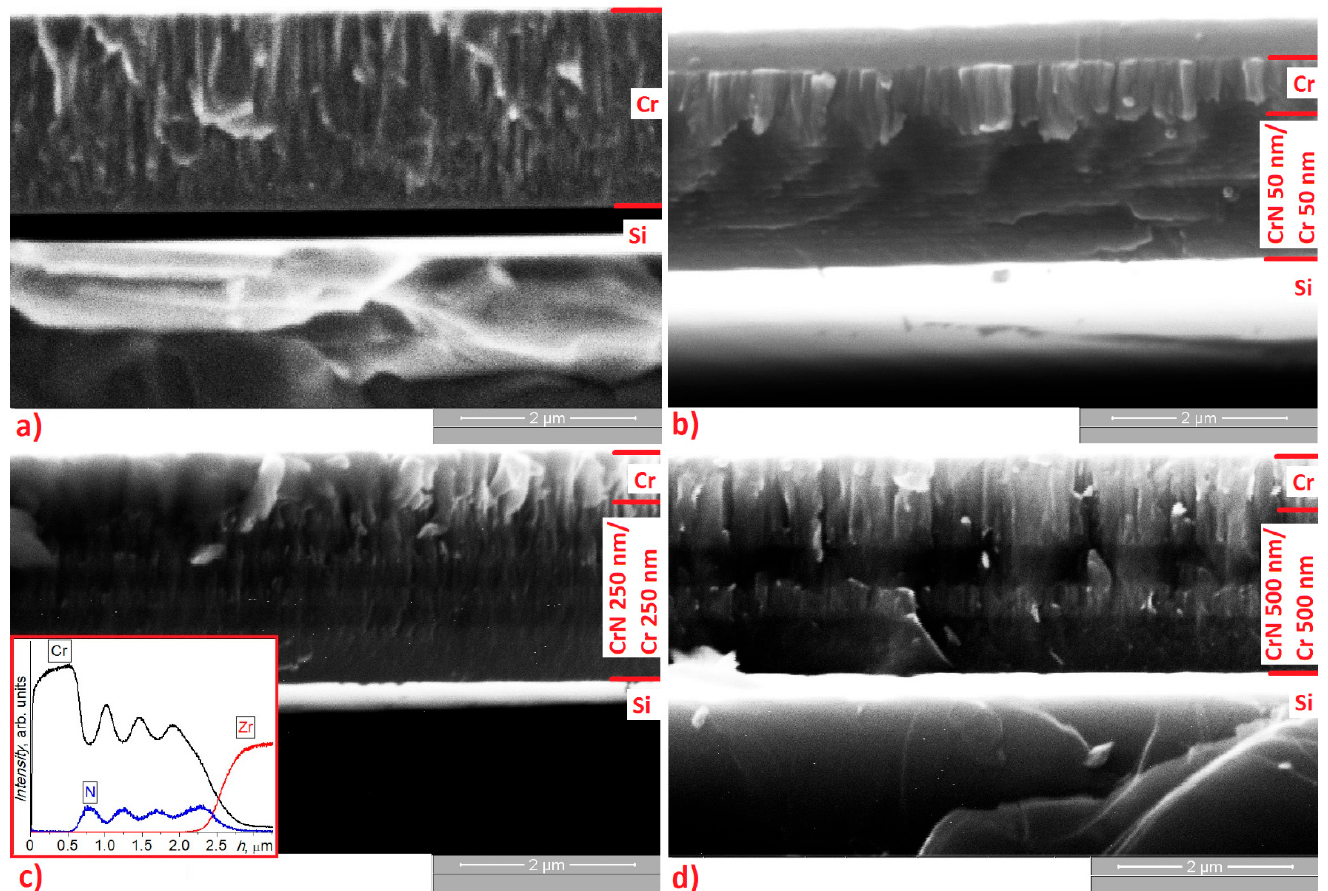
Figure 2. The cross-section SEM images of the as-deposited coatings on Si substrate: ( a ) Cr coating; ( b ) CrN/Cr-50 coating; ( c ) CrN/Cr-250 coating; ( d ) CrN/Cr-500 coating. Elemental depth distribution in the CrN/Cr-250 sample is shown.